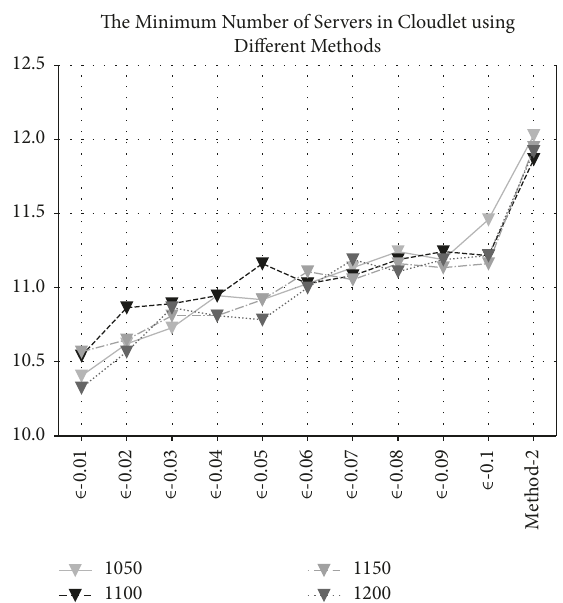
Figure 12: The minimum number of servers in Cloudlet using different methods.